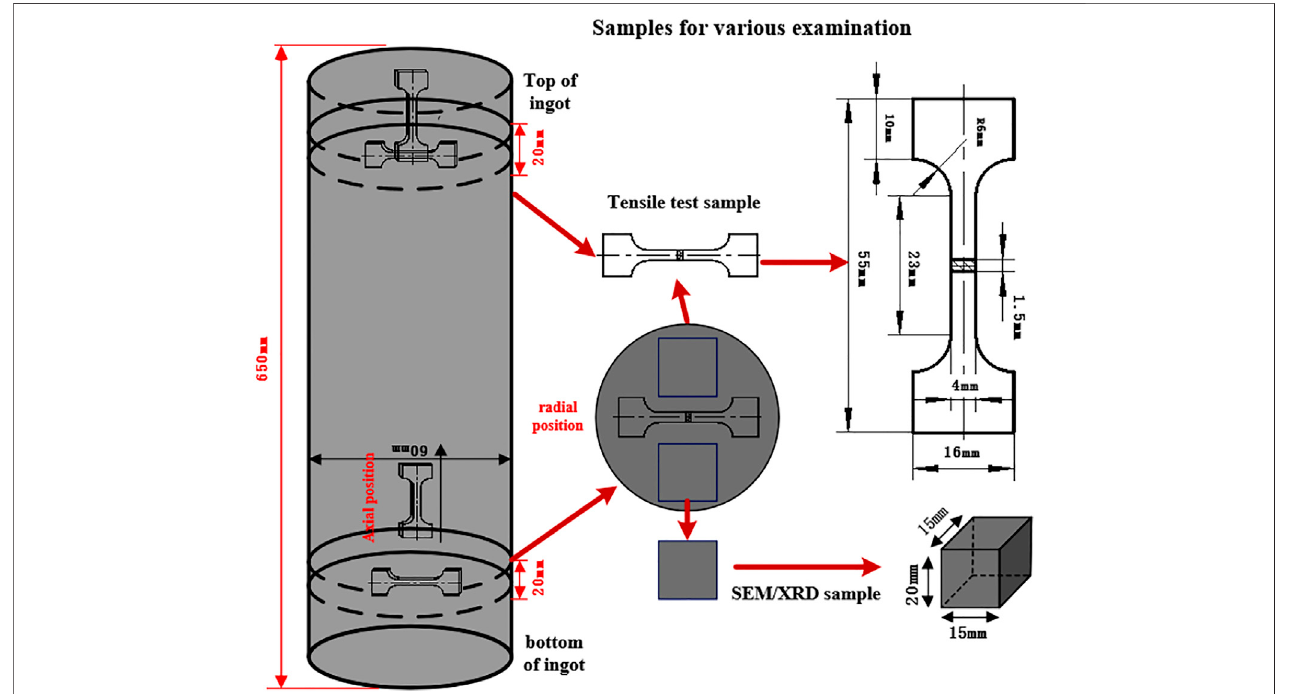
FIGURE 2 | Schematic graph showing agent positions of microstructure tests and ductile tests taken from the ingot.